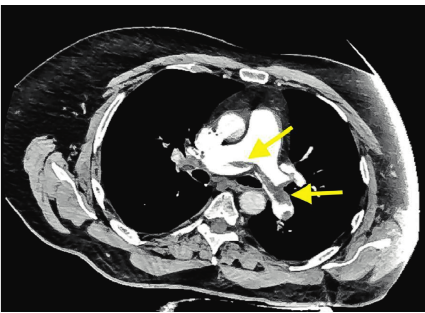
Figure 1: Computed tomography angiography (CTA) of the chest showing bilateral pulmonary embolism (yellow